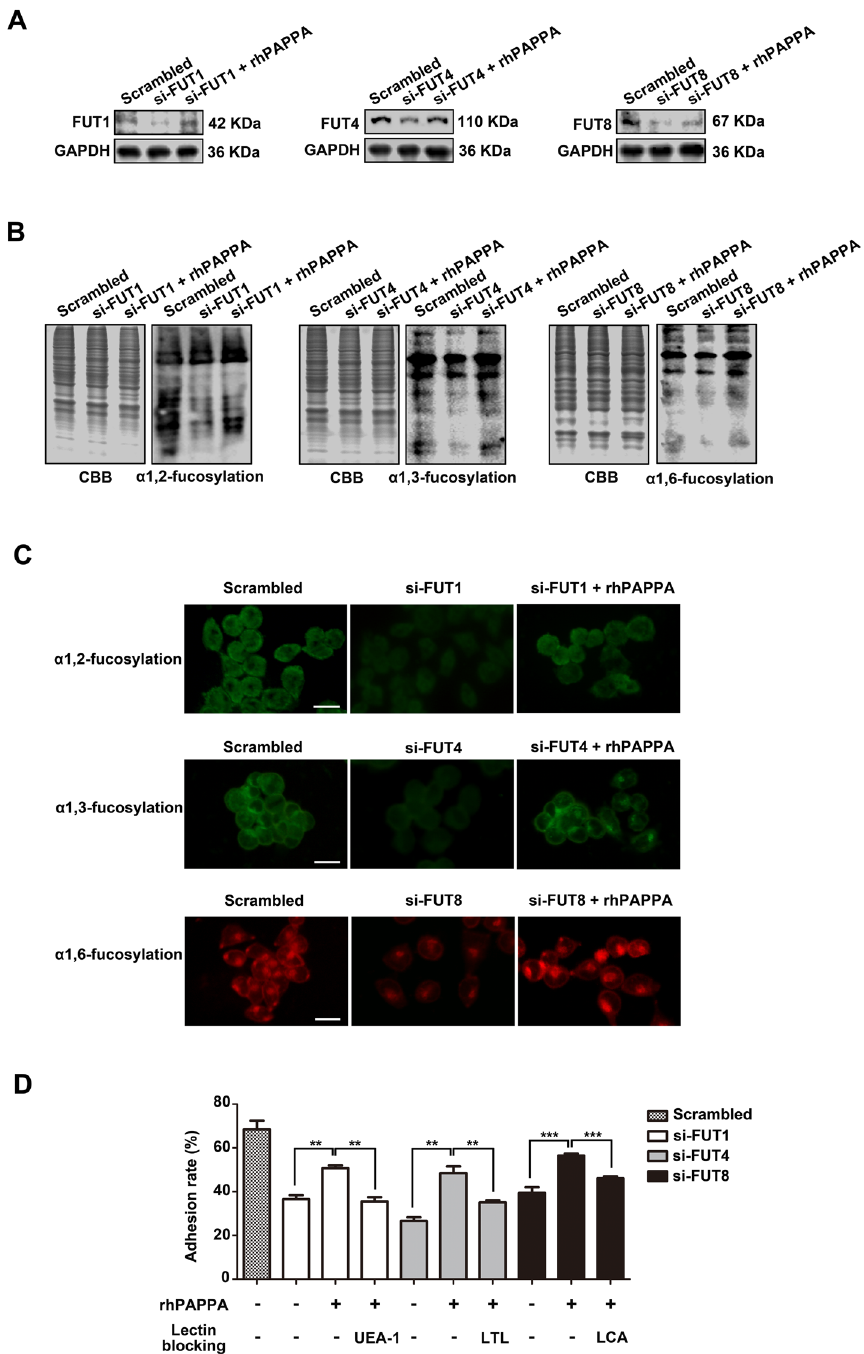
Figure 4. rhPAPPA rescues the impaired receptivity through up-regulating specific N-fucosylation. Ishikawa cells were differently transiently transfected with siRNA specific to FUT1, FUT4, FUT8 or scrambled control in the absence or presence of rhPAPPA. (A ) Western blotting was performed to detect the expression of FUT1/4/8. ( B ) Lectin blotting and ( C ) Lectin fluorescent staining showed the specific N-fucosylation level. ( D ) Adhesion rate of JAR cells to FUT1/4/8 siRNA-transfected Ishikawa cells in the absence or presence of rhPAPPA, UEA-1, LTL or LCA, respectively, followed by analysis. GAPDH was used as an internal control. The bar represents 50 μ m. ** p < 0.01, *** p < 0.001. The data were presented as the means ± SEM of three independent